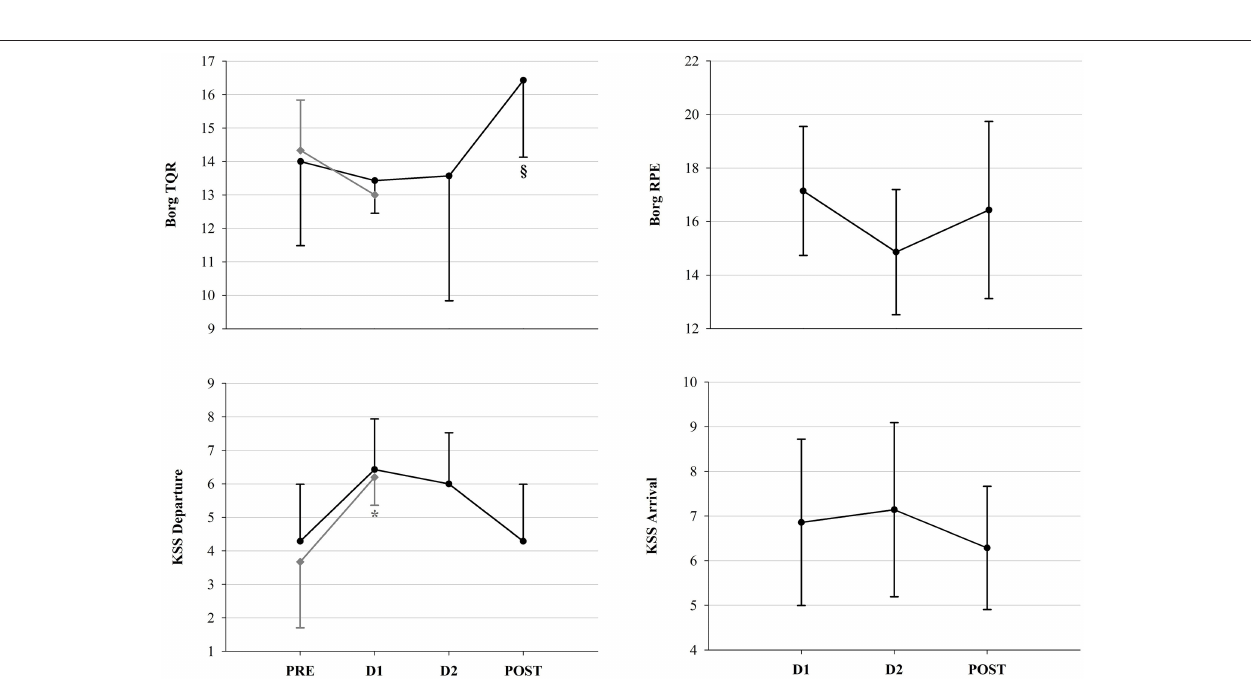
FIGURE 8 | Fatigue scale scores. Borg and KSS scores in FIN (black line) and in NON (gray line) across time-points. * p < 0.05 vs. PRE within subgroup; § p < 0.05 vs. D1 (One-Way RM ANOVA).